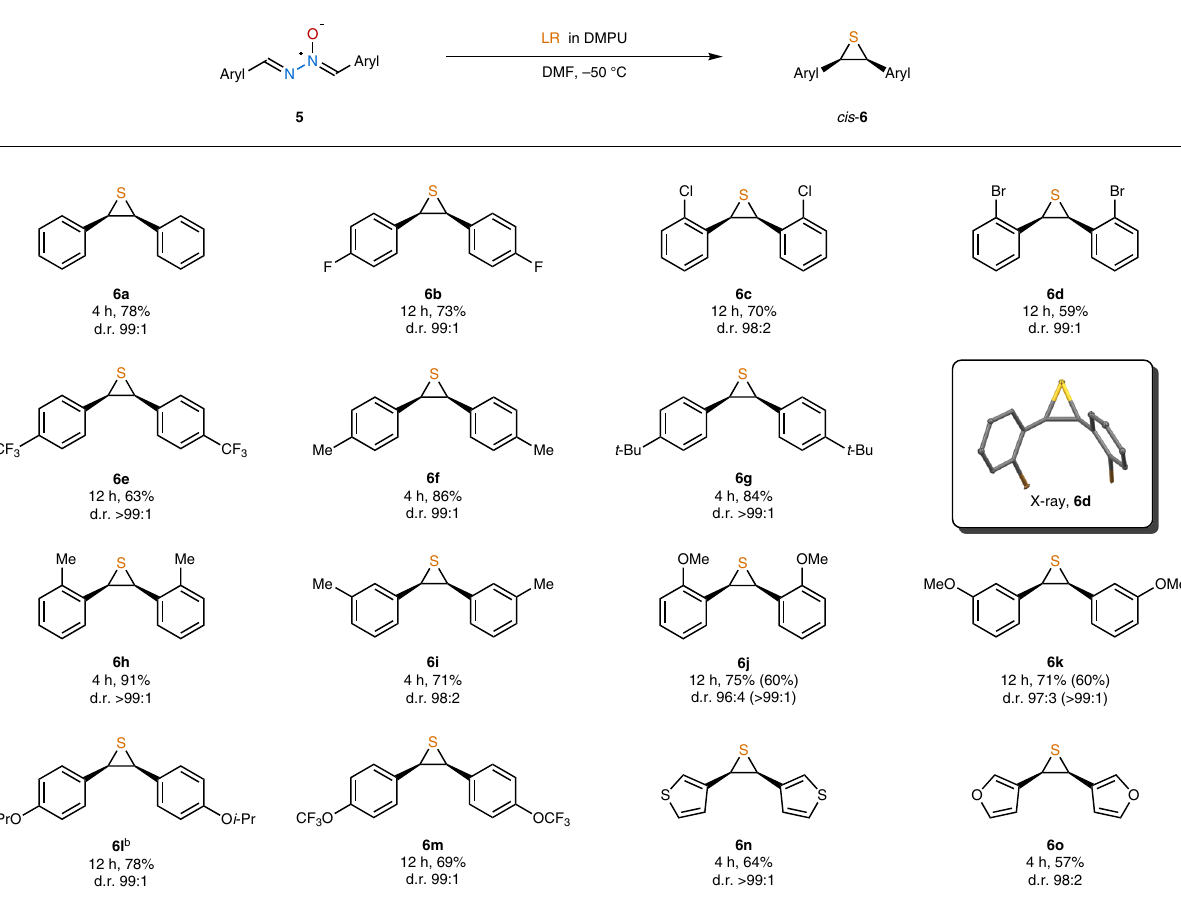
determinedby 1 HNMR analysisoftheisolated material.Data after recrystallization are given in the parenthesis. b Contaminated by alkene (86:14).